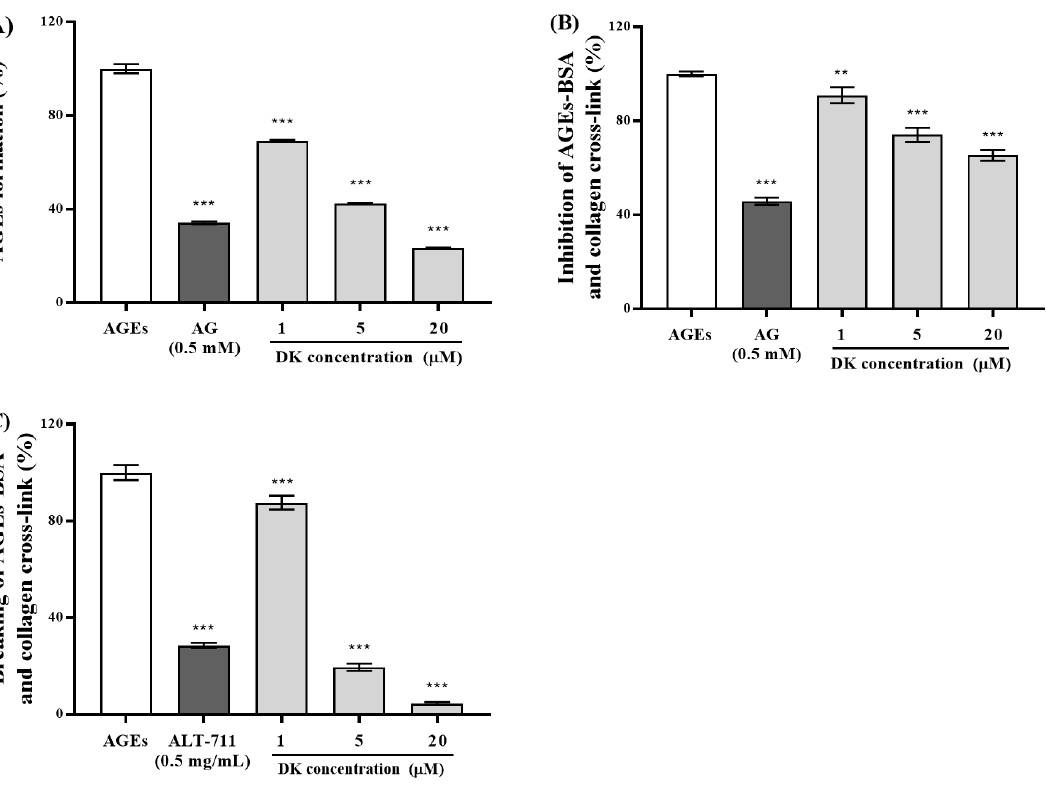
Figure 1. The inhibitory ability of dieckol (DK) isolated from Ecklonia cava ( E. cava ) on an in vitro glycation reaction: ( A ) evaluation of DK’s ability to inhibit AGE formation; ( B ) evaluation of DK’s ability to inhibit cross-linking formation between AGE and collagen; ( C ) evaluation of DK’s ability to break cross-links formed between AGE and collagen. All experiments were independently repeated three times. Data are presented as mean ± standard deviation ( n = 3) (** p < 0.01 and *** p < 0.001 vs. AGE).